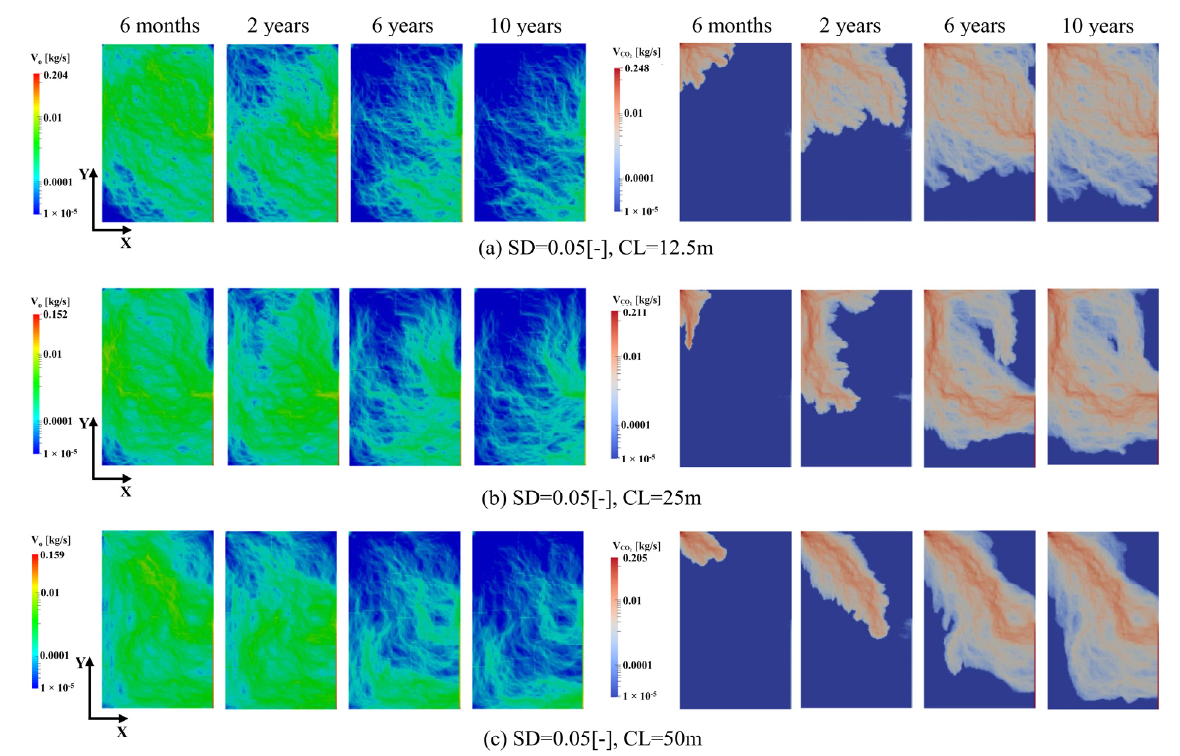
Figure 12. Evolutions of oil and CO 2 flow fields of Set 1. ( a ) SD = 0.025 (-), CL = 12.5 m; ( b ) SD = 0.025 (-), CL = 25 m; ( c ) SD = 0.025 (-), CL = 50 m.